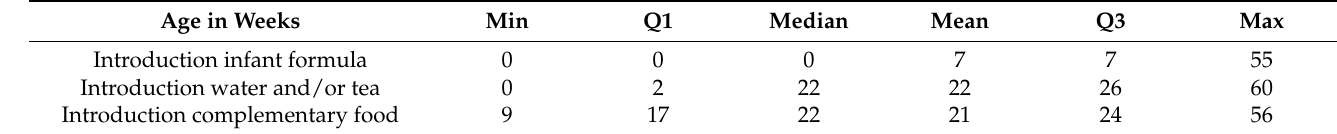
Table 3. Age in completed weeks when other liquids/foods were